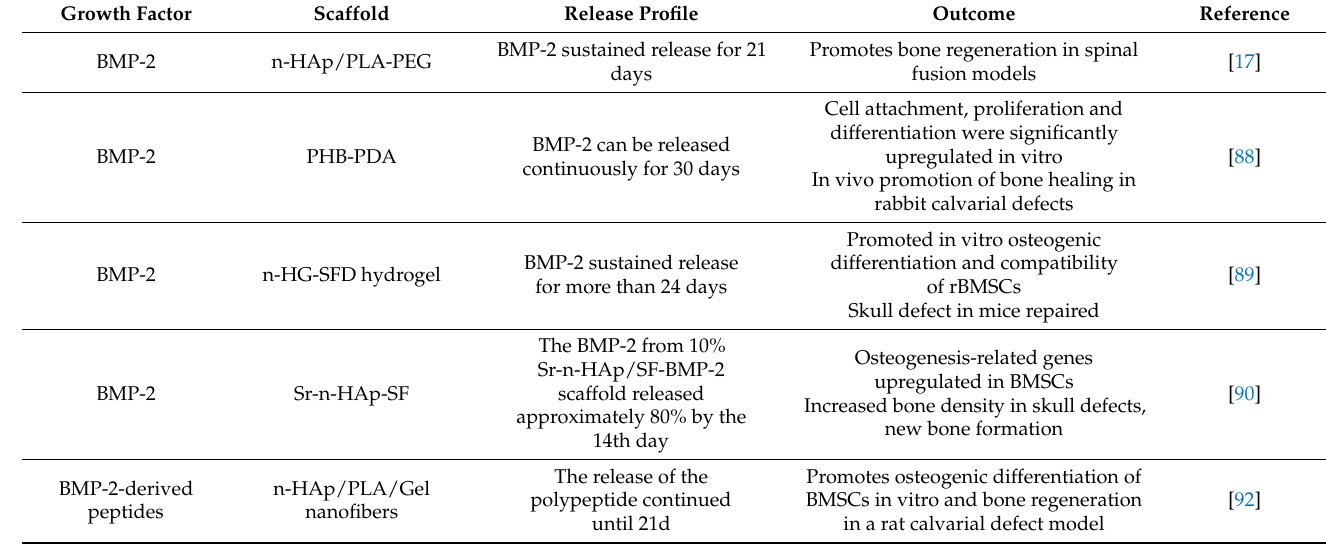
Table 2. Summary of the growth factor-loaded n-HAp composites for bone